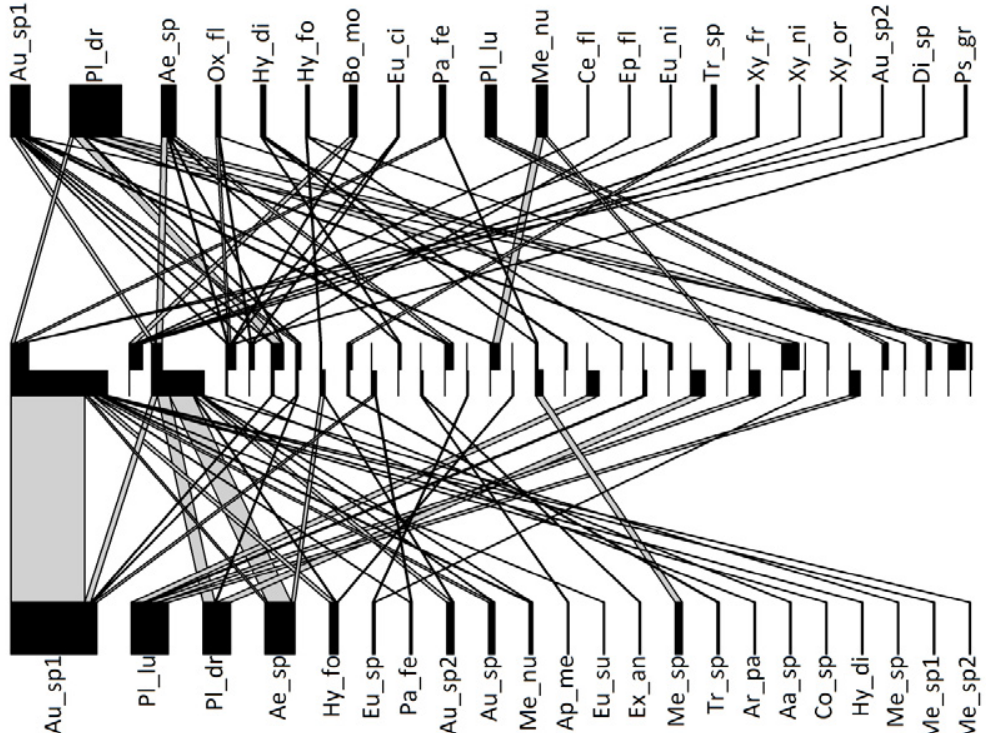
Fig 2 . Bee-plant interactions in tropical Atlantic Forest at Itaoca Inselberg, southeastern Brazil. The species are represented by bars: plant species in the center and bee species on bottom (wet season) and top (dry season). The size of links indicates the number of interactions. The acronyms of plants from left to right are: Au_sp, Ct_sp, Sp_ve, So_he, So_co, Si_rh, So_sp1, Ve_ph, Mu_pa, Em_so, Bi_pi, Mo_ch, Oc_ba, Co_be, Ps_sp, Ce_sp, St_ca, As_cu, Fa_ca2, Cn_sp, Fa_ca3, Co_sp, In_la, Ja_co, Am_ma, Cr_sp, Ti_sp, Ch_sp, Pe_ru, Fa_ca1, Pi_go, Le_sp, Pa_si, Au_fa. The acronyms are according to Tables 1 and